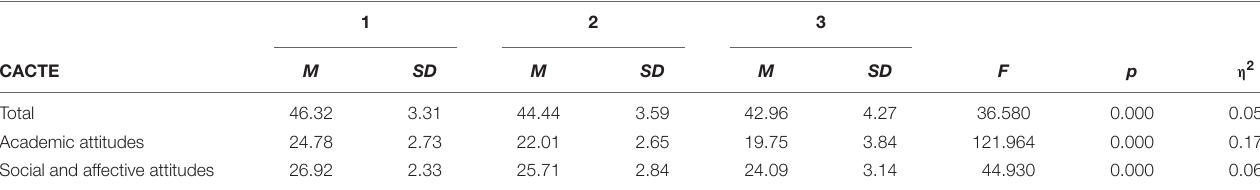
TABLE 6 | ANOVA CACTE/Groups’ preference for teamwork/working alone.